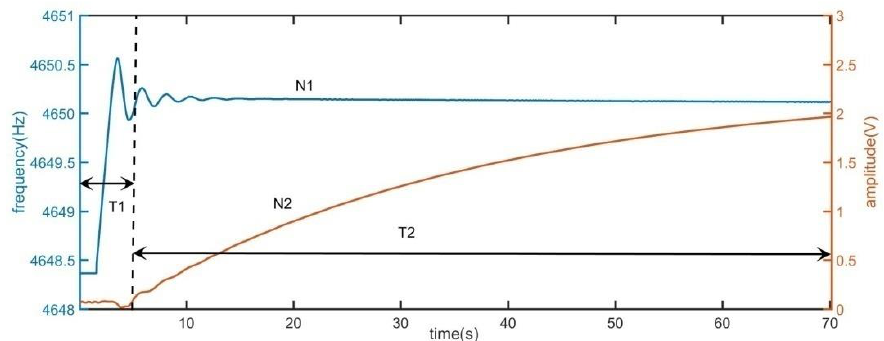
Figure 2. The start-up time of MEMS disk resonator gyroscope.